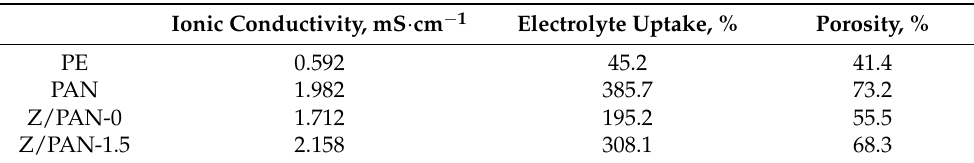
Table 1. The ionic conductivity, electrolyte uptake, and porosity of different separators soaked with electrolytes at room temperature.